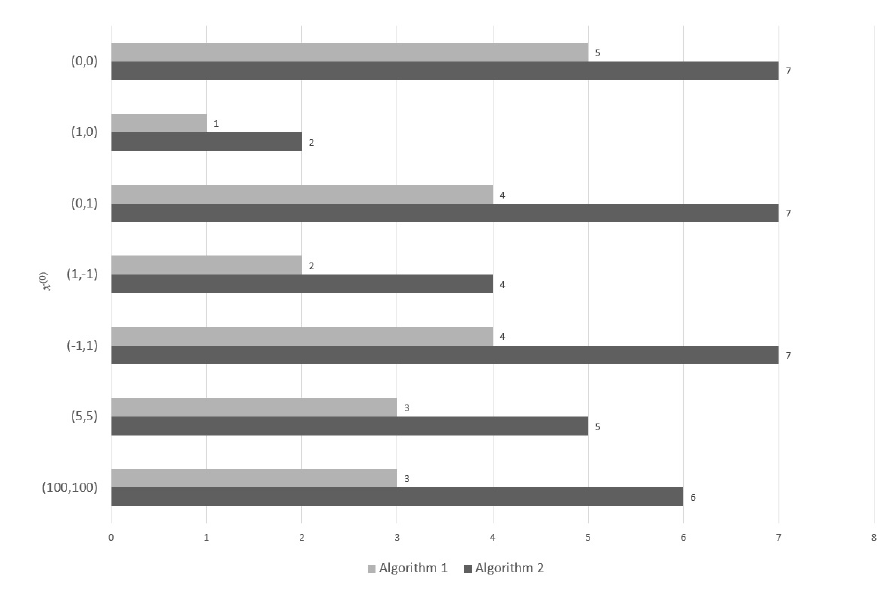
Figure 2. Number of iterations for various starting points (for Example